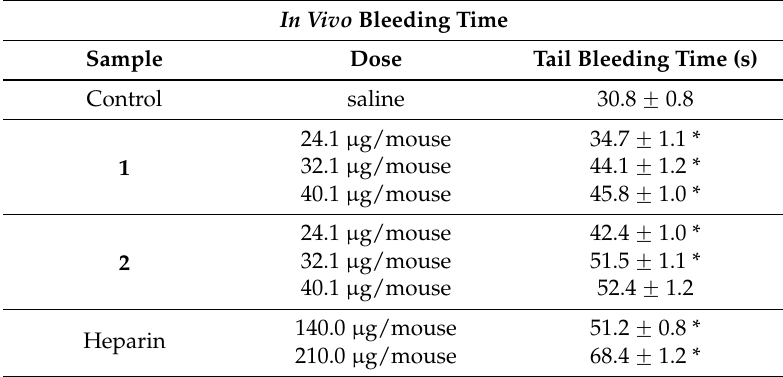
Table 3. In vivo bleeding time of 1 and 2 .